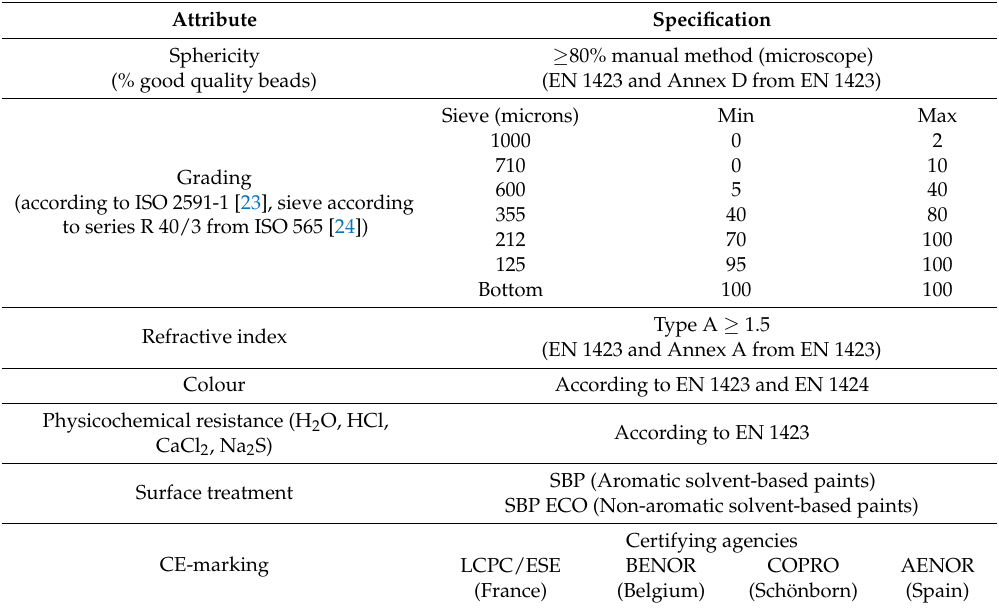
Table 4. Echostar 5 glass microbeads